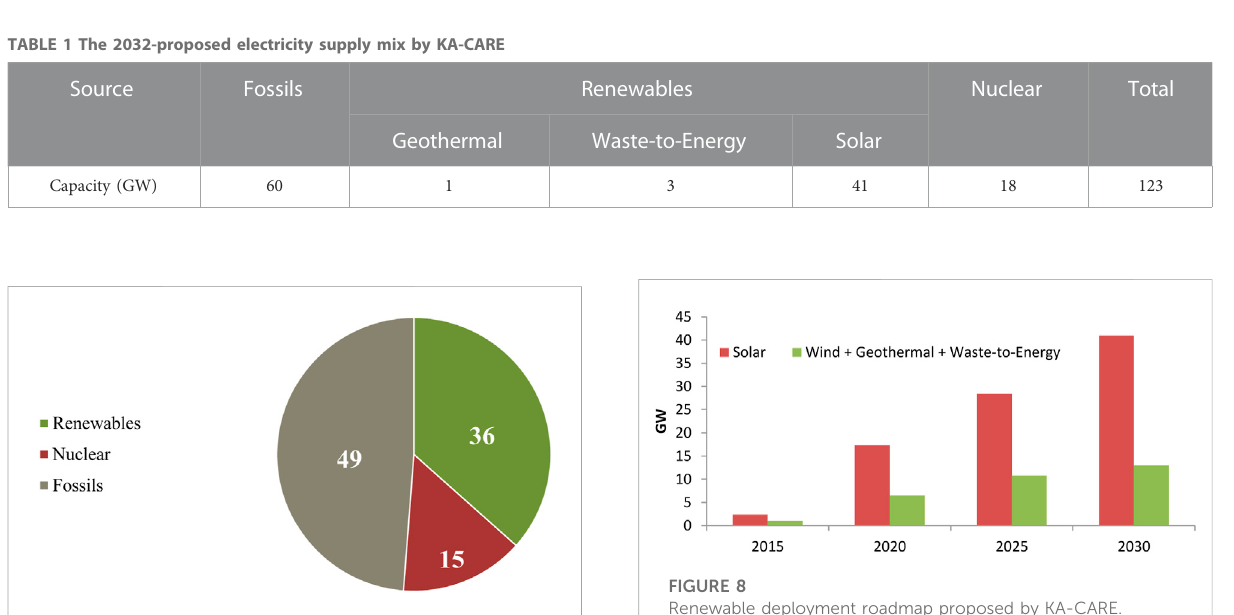
FIGURE 7 Contribution percentage of sources to power generation capacity, 2032.